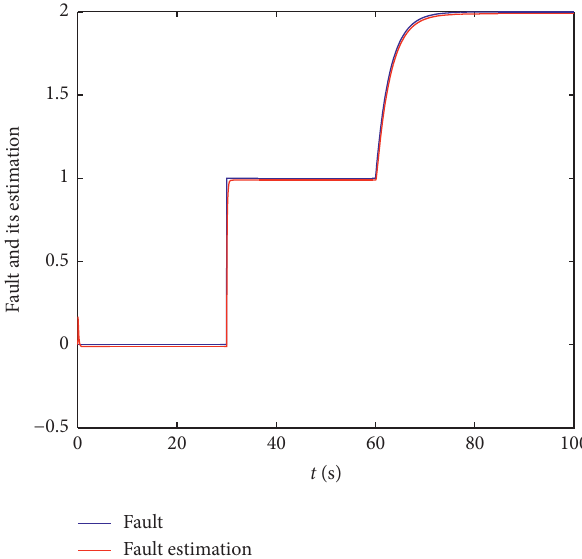
Figure 3: Fault and fault